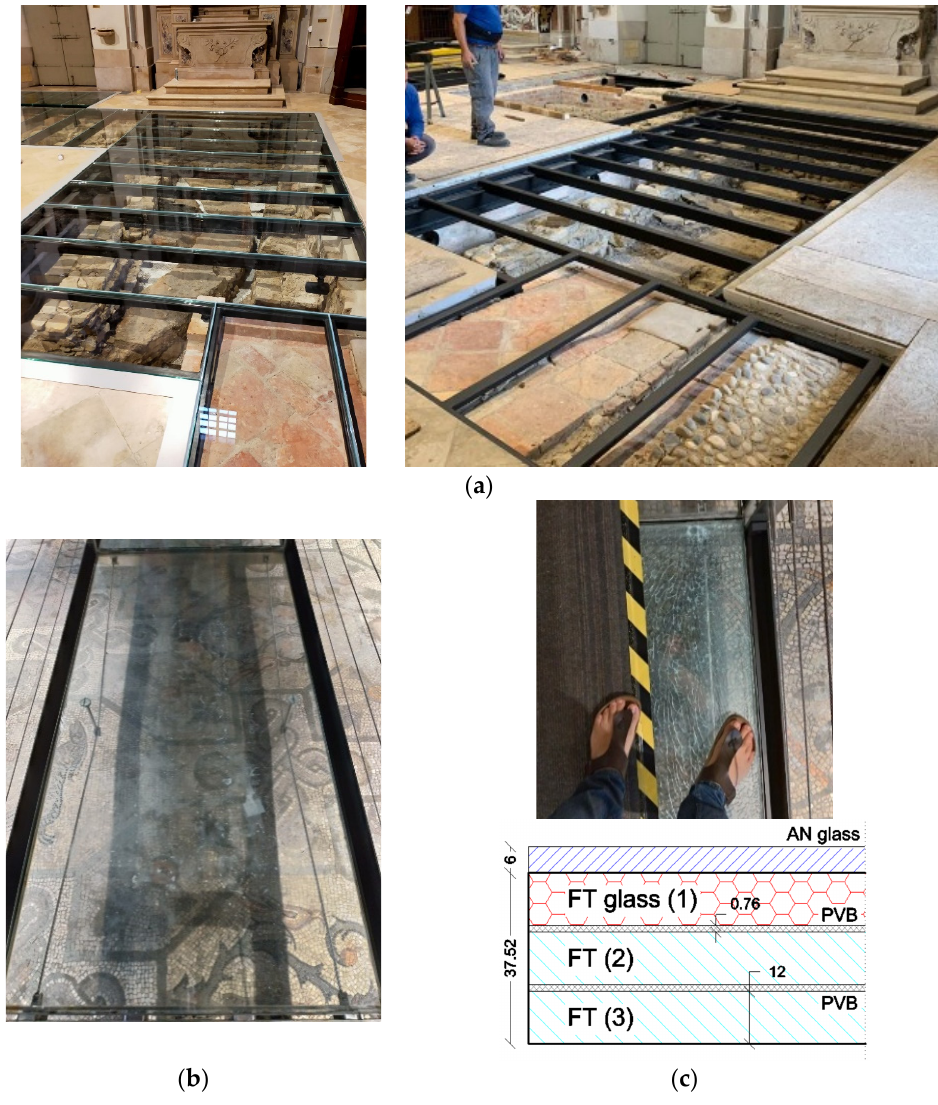
Figure 7. Overview of selected modular units for the examined LG pedestrian systems: ( a ) SM#1–LGU layout (pictures taken during retrofit interventions in Spring 2021, Courtesy of Seretti Vetroarchitetture); ( b ) top view of SM#2–LGU modular unit (reproduced from [19] under the terms and conditions of CC-BY license); and ( c ) schematic representation of glass fracture detail for SM#3–LGF panel.